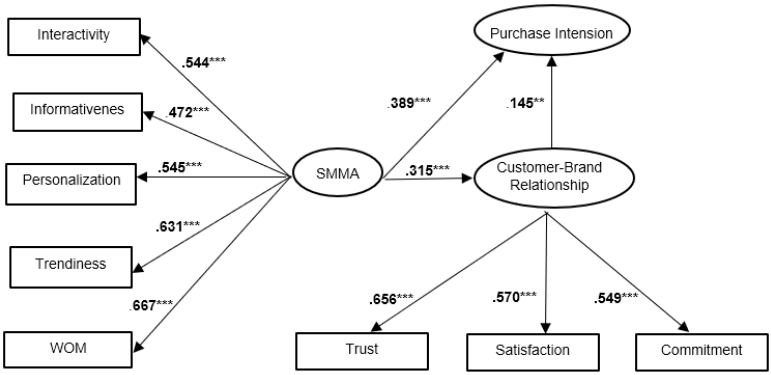
Figure 2. Flow diagram of results obtained on SEM (*** p < 0.001; ** p < 0.005).